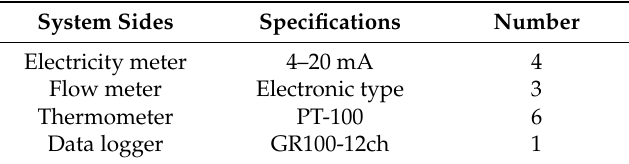
Table 2. Monitoring equipment.